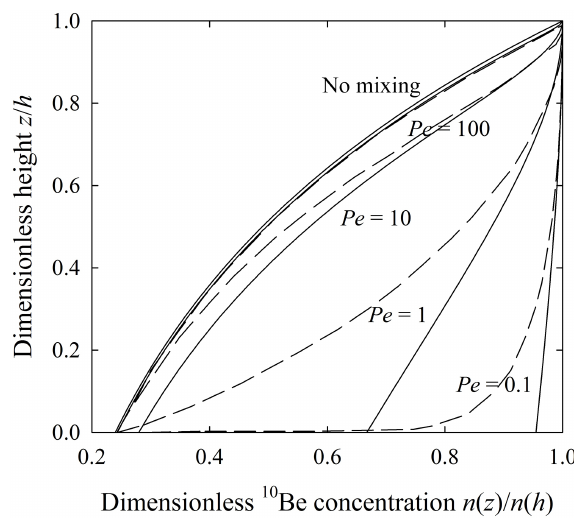
Figure 12. Plot of dimensionless expected concentration ˆ n ( ˆ z ) = n ( z ) /n ( h ) of 10 Be atoms versus dimensionless height ˆ z = z/h with uniform mixing (solid lines) and nonuniform mixing (dashed lines) as these vary with the Péclet number Pe = Wh/K z .